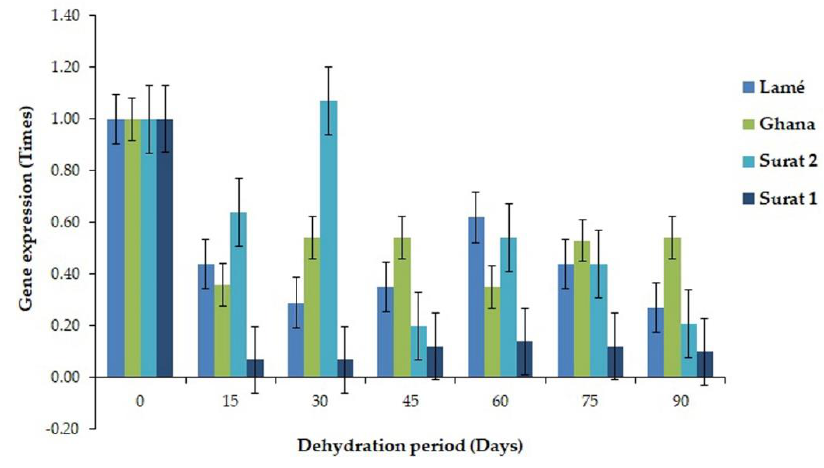
Figure 4. Gene expression value of PIF1 helicase, putative gene in the leaf of different oil palm varieties at varying periods of water deficit.